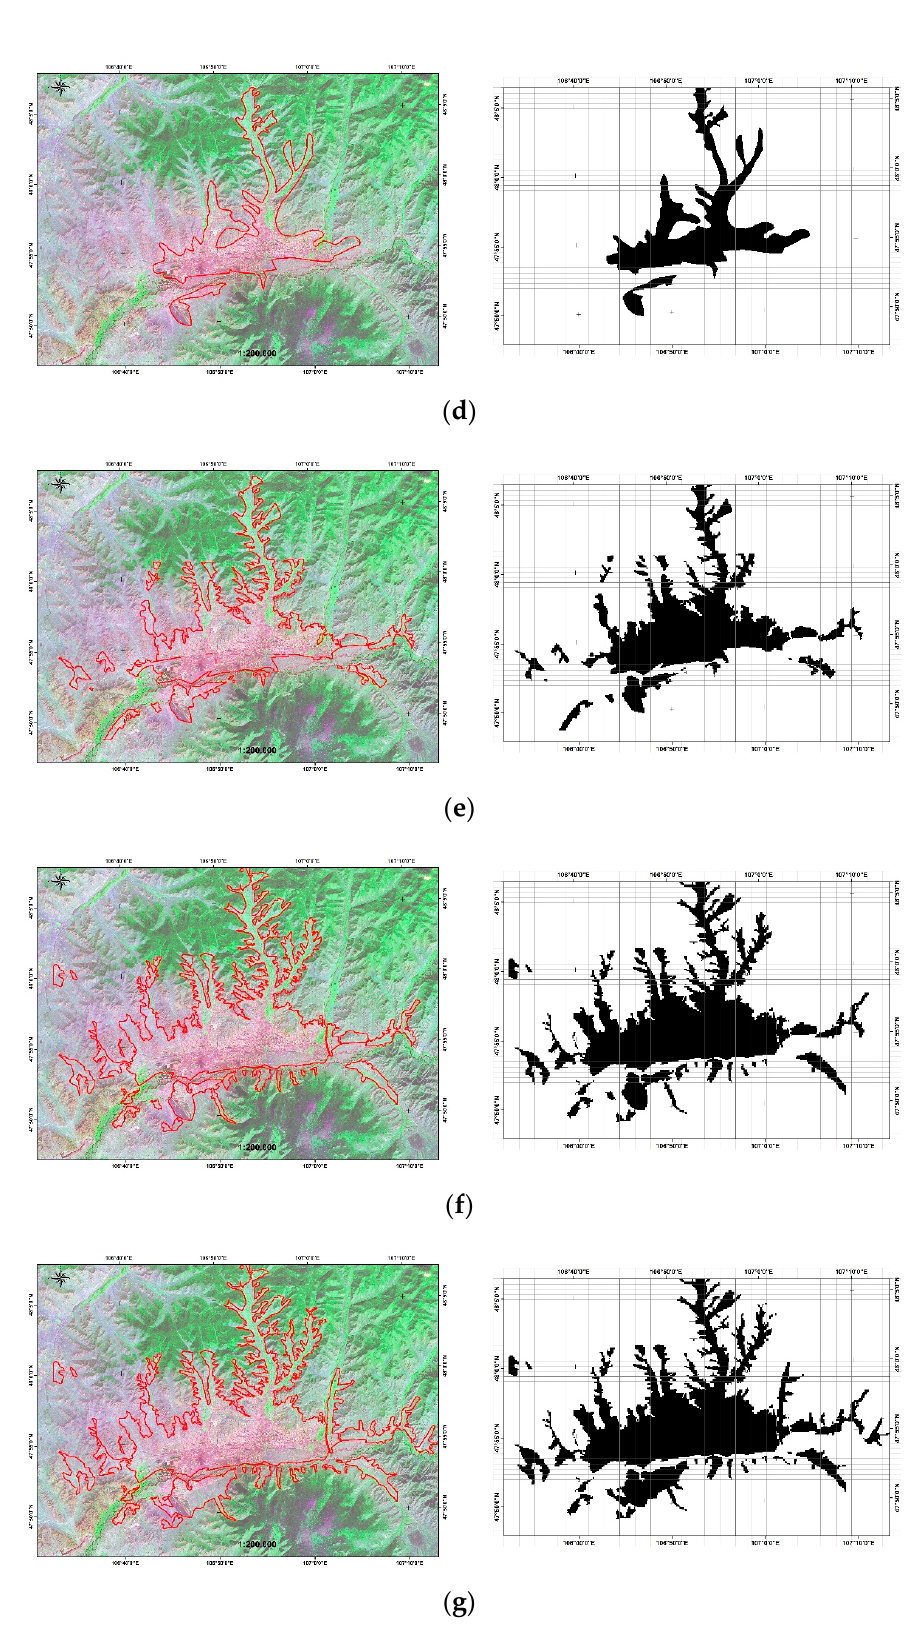
Figure 3. Map of the urban sprawl showing increases of ( a ) 10,730 ha by 1990; ( b ) 11,270 ha by 1995; ( c ) 15,141 ha by 2000; ( d ) 17,326 ha by 2005; ( e ) 26,541 ha by 2010; ( f ) 36,025 ha by 2015; and ( g ) 39,235 ha by